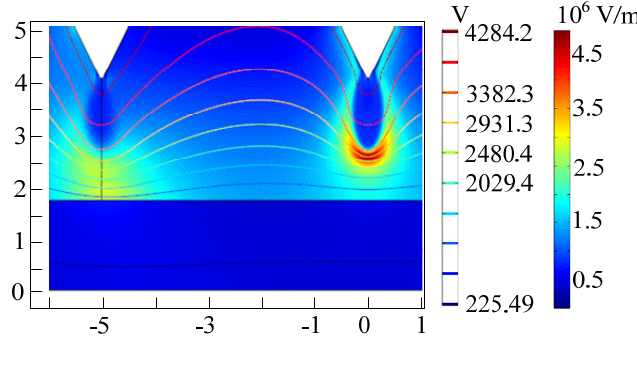
Figure 9. Electric field and potential isoline distribution of partial domain in